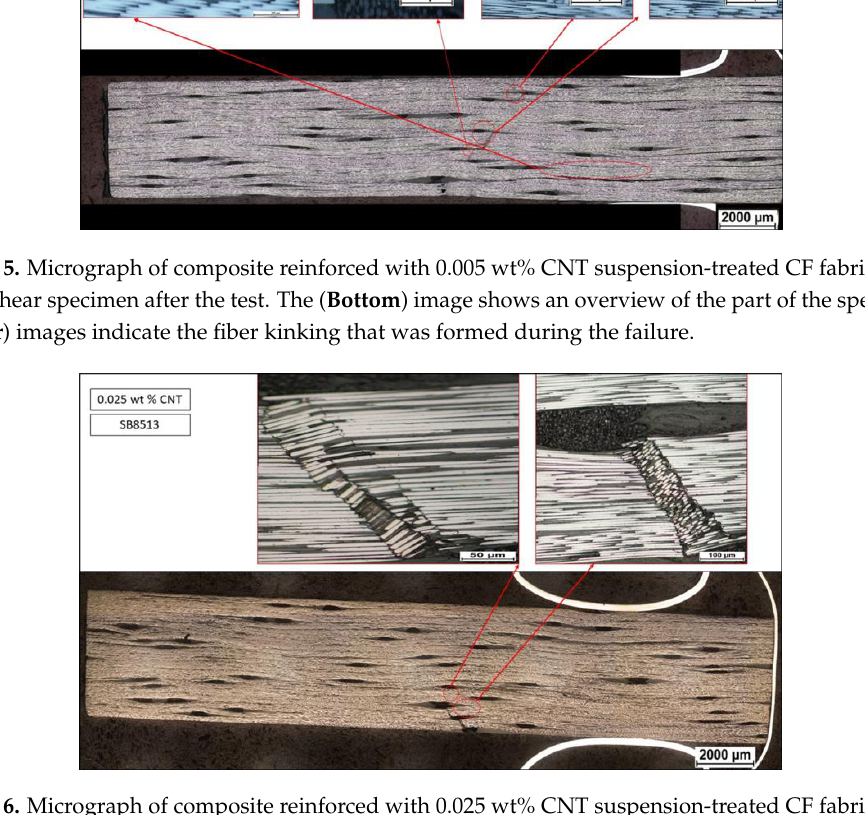
Figure 6. Micrograph of composite reinforced with 0.025 wt% CNT suspension-treated CF fabric short beam shear specimen after the test. The ( Bottom ) image shows an overview of the part of the specimen. The ( Upper ) images indicate the fiber kinking that was formed during the failure. Fibers 2018 , 6 , x FOR PEER REVIEW 10 of 12